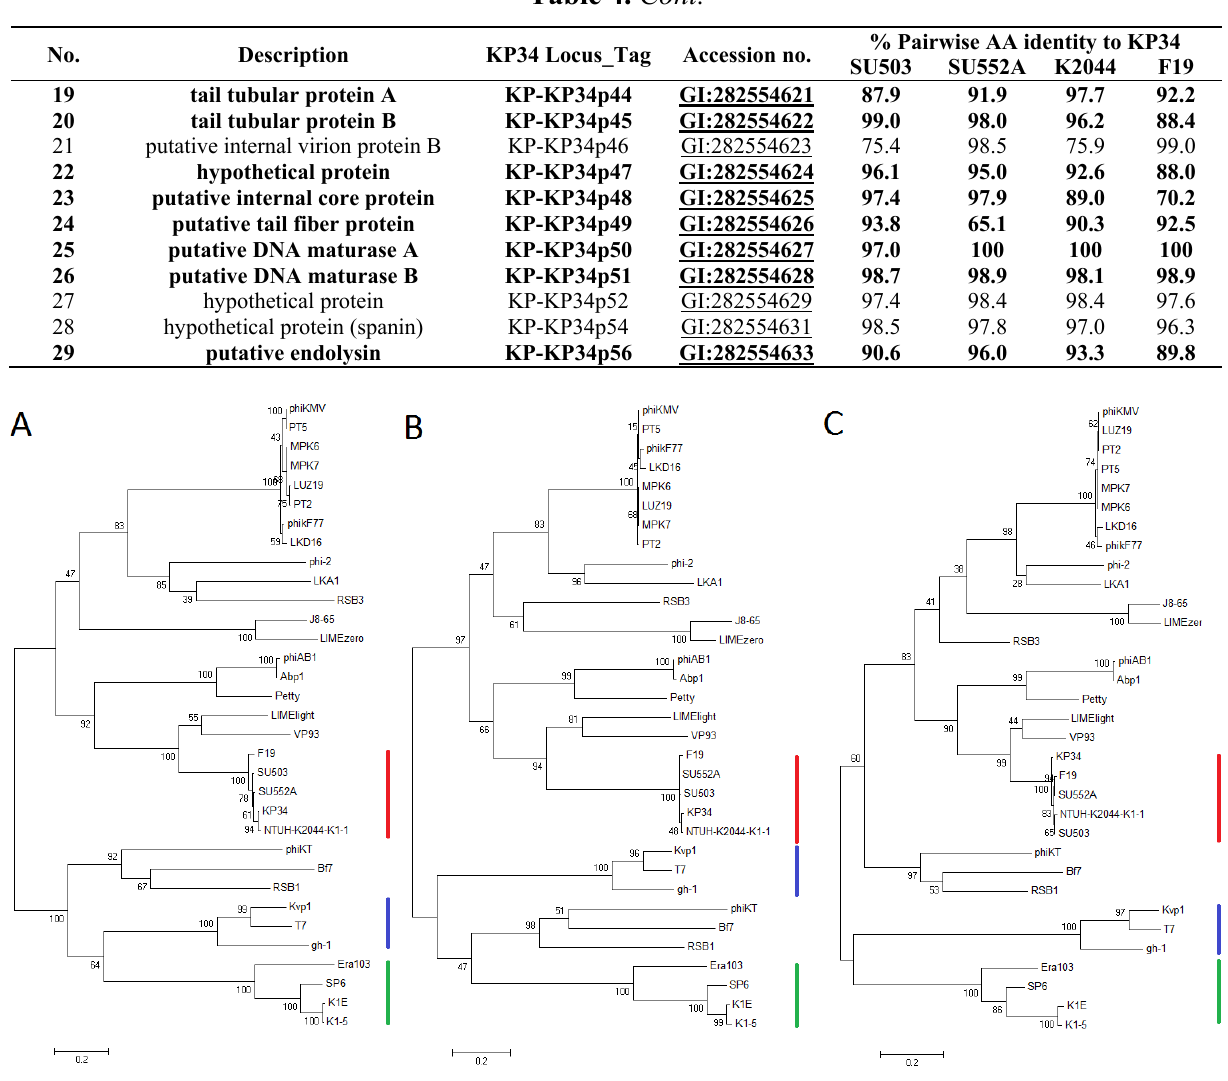
Figure 4. The phylogenetic analyses of amino acid sequences, inferred from three genes from 33 phages in the Autographivirinae subfamily, were performed by using the maximum likelihood (ML) method based on the Whelan and Goldman model [30], with 500 bootstrap replicates. The bootstrap percentages are shown next to each node. Initial trees for the searches were autogenerated by the maximum parsimony (MP) method. The following ML searches were performed using uniform substitution rates among sites and the Nearest-Neighbor-Interchange (NNI) heuristic search method. Positions containing gaps and missing data were excluded. The trees with the highest likelihoods are drawn to scale, with branch lengths measured in the number of substitutions per site. Red lines indicate the “Kp34likevirus” cluster, blue T7likevirus members and green SP6likevirus members. Phikmvlikevirus members’ φKMV, LKA1, LIMElight and LIMEzero are scattered in the upper clade of the phylograms. The analyses were conducted in MEGA6 [28]. ( a ) The RNA polymerase tree (log likelihood = −26580.7487); ( b ) The head-tail connector protein tree (log likelihood = −12447.9348); ( c ) The DNA maturase B (terminase) tree (log likelihood =